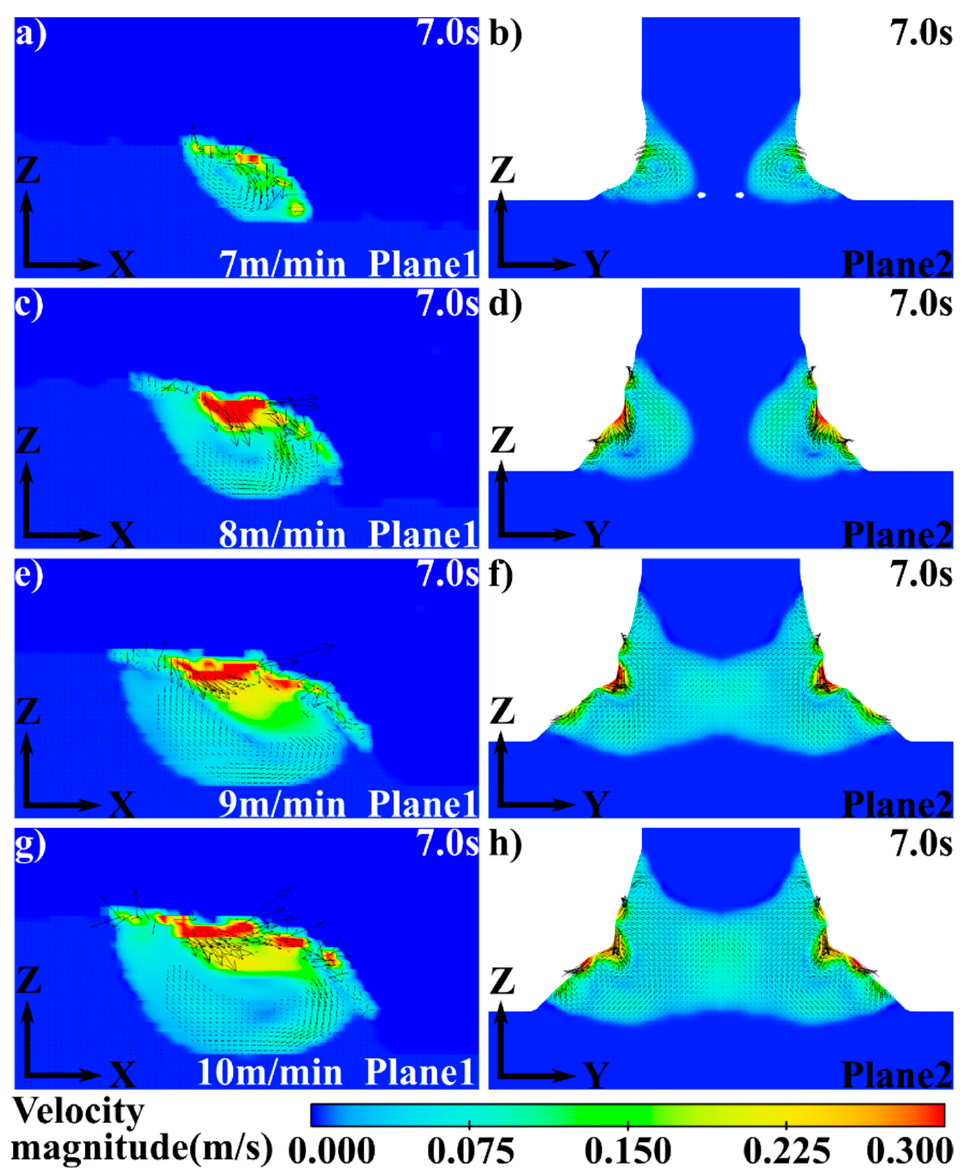
Figure 10. Velocity distributions on the longitudinal sections: wire feed speeds of ( a ) 7 m/min, ( c ) 8 m/min, ( e ) 9 m/min, and ( g ) 10 m/min; velocity distributions on the cross sections: wire feed speeds of ( b ) 7 m/min, ( d ) 8 m/min, ( f ) 9 m/min, ( h ) 10 m/min.